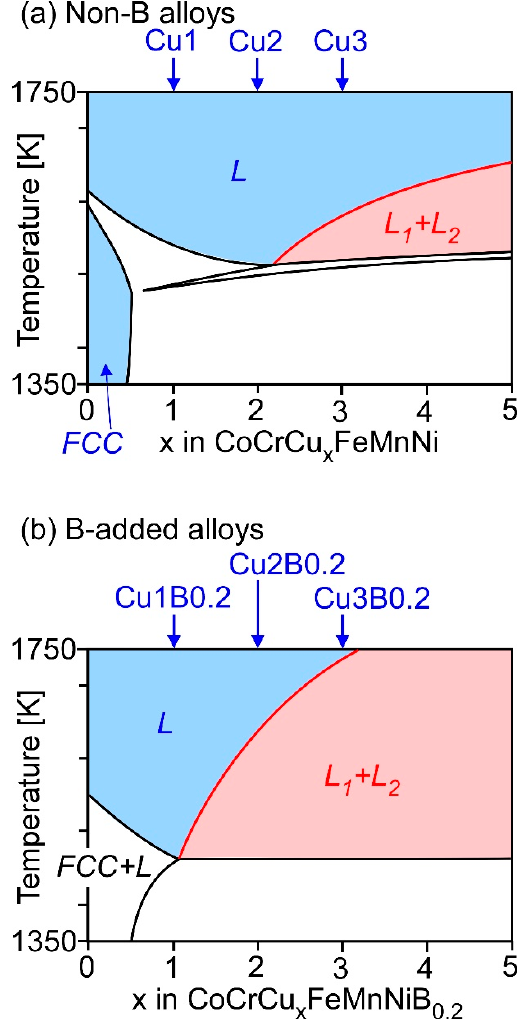
Figure 14. Calculated phase diagram of the pseudo-binary CoCrFeMnNi-CoCrCu 5 FeMnNi and CoCrFeMnNiB 0.2 -CoCrCu 5 FeMnNiB 0.2 focusing on LPS. The liquid miscibility gap is shown using a red line. ( a ) CoCrFeMnNi-CoCrCu 5 FeMnNi and ( b ) CoCrFeMnNiB 0.2 -CoCrCu 5 FeMnNiB 0.2 . Table 4. Chemical composition of the separated liquid in CoCrCu 2 FeMnNiB 0.2 (Cu2B02) alloys estimated by the thermodynamic calculations. (a) Cu-rich liquids, (b) Cu-poor liquids.